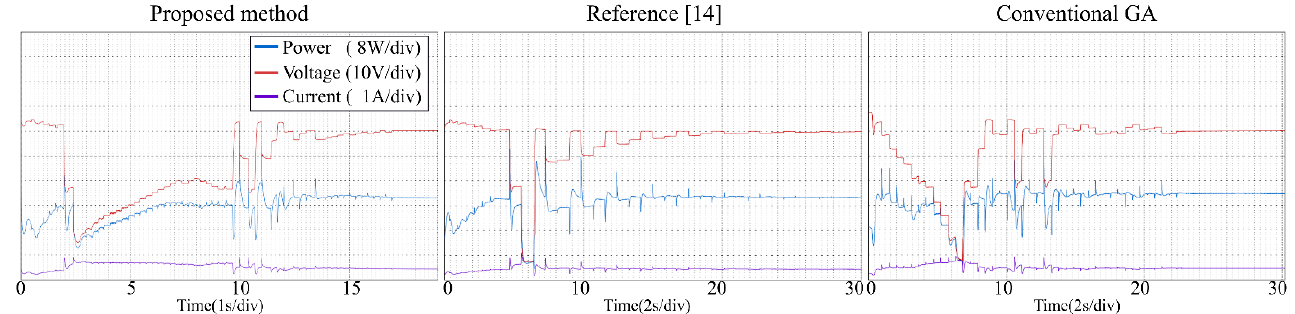
11 of 14 Figure 14. Tracking process—Pattern 2. Figure 15. Tracking process—Pattern 3.